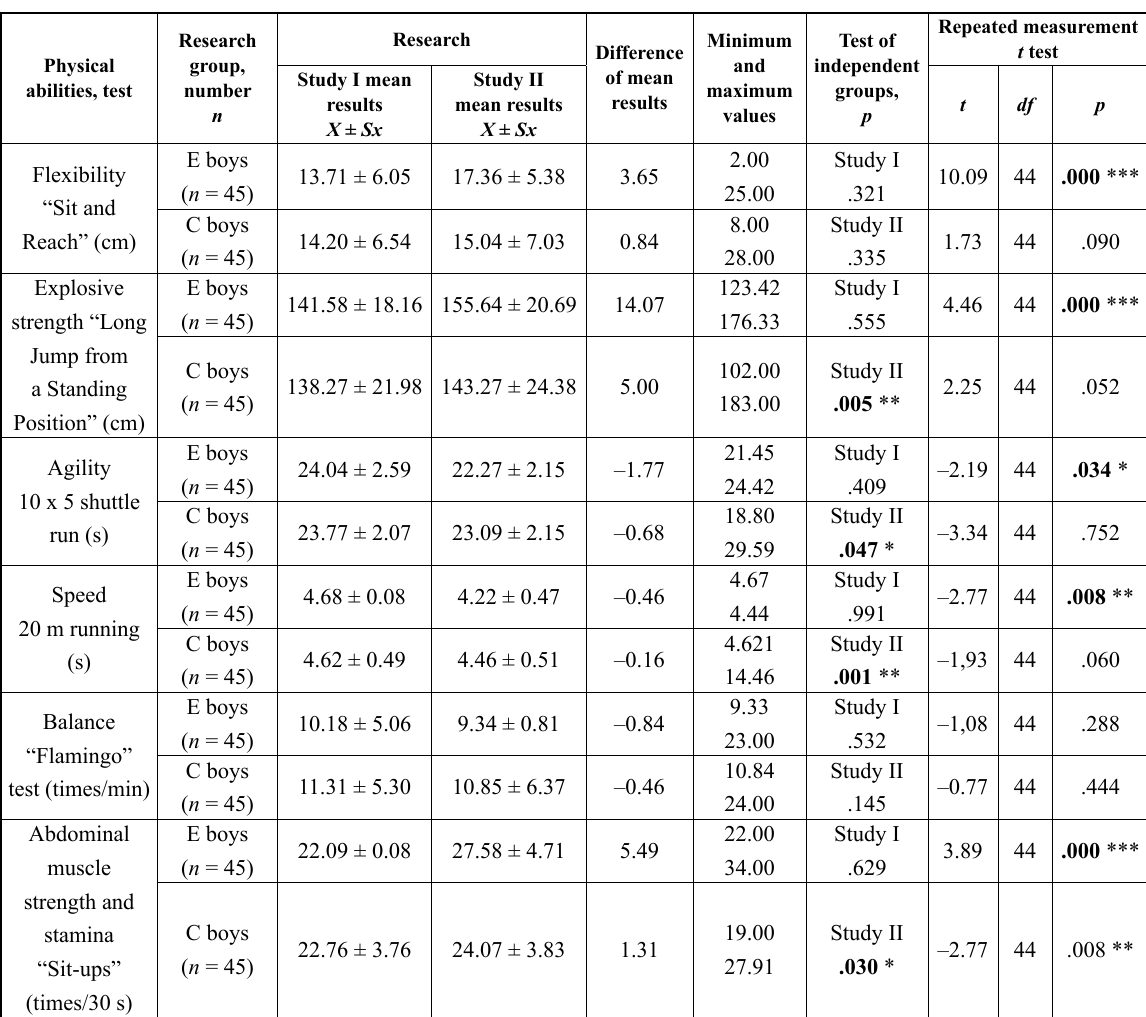
Table 2. Change results of boys’ physical abilities